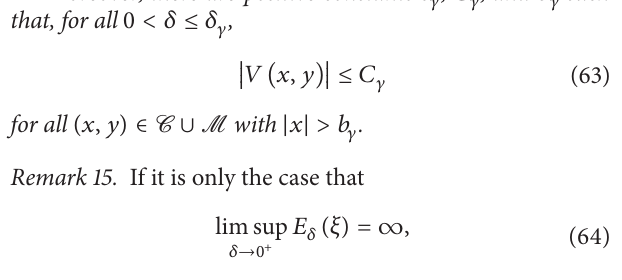
such as dipoles such that, for any 0 < 𝜉 ≤ 𝑎 , 𝐸 𝛿 (𝜉) → ∞ if 𝑑 0 is “close enough” to 𝑎 and 𝐸 𝛿 (𝜉) ≤ 𝐶 𝛾 for some positive constant 𝑑 𝐶 𝛾 if 0 is “far enough away” from depend on 𝛾